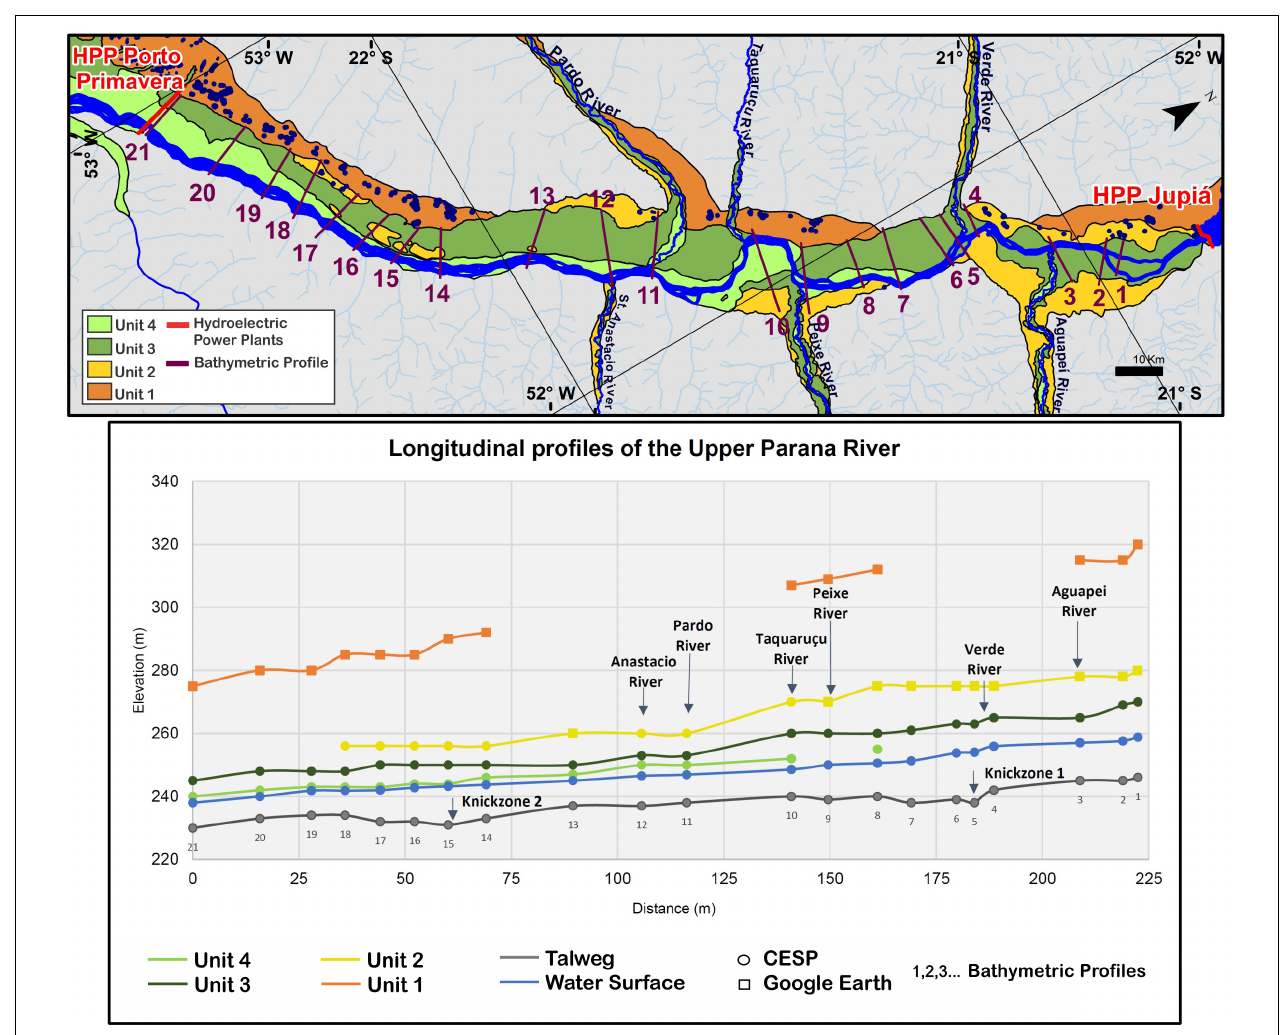
FIGURE 7 | Longitudinal profiles of the current channel and terrace levels identified in the study area. The data was obtained from topobathymetric sections elaborated by Cia Energética de São Paulo [CESP] (1997) and data obtained from Google Earth software. Knickpoints were identified based on present day thalweg profile. The arrows with the names of the tributaries indicate location of the confluences of the tributaries with the Paraná